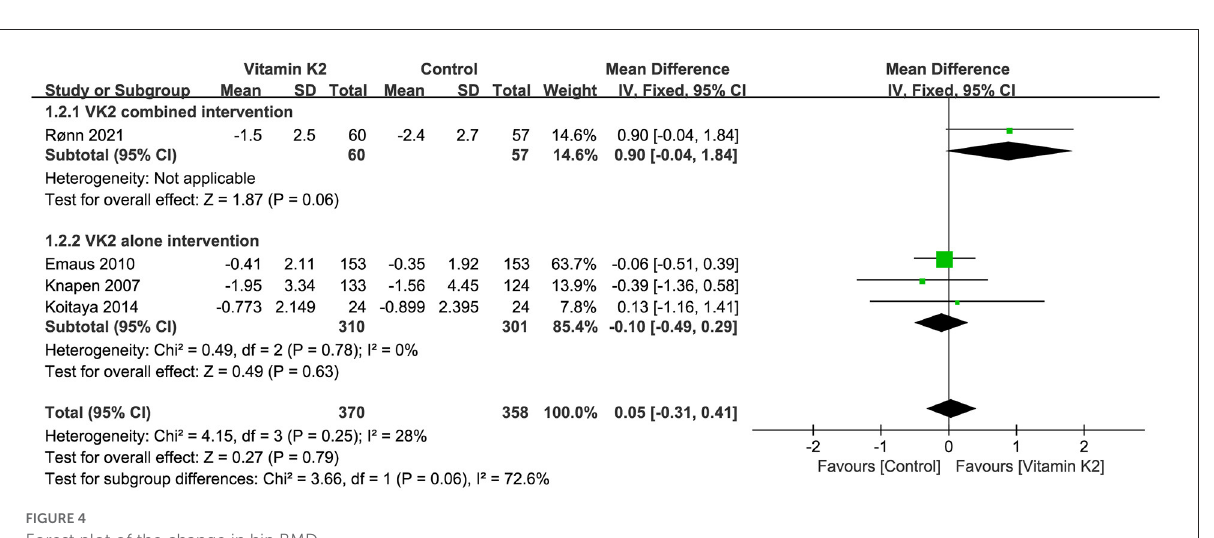
FIGURE4 Forest plot of the change in hip